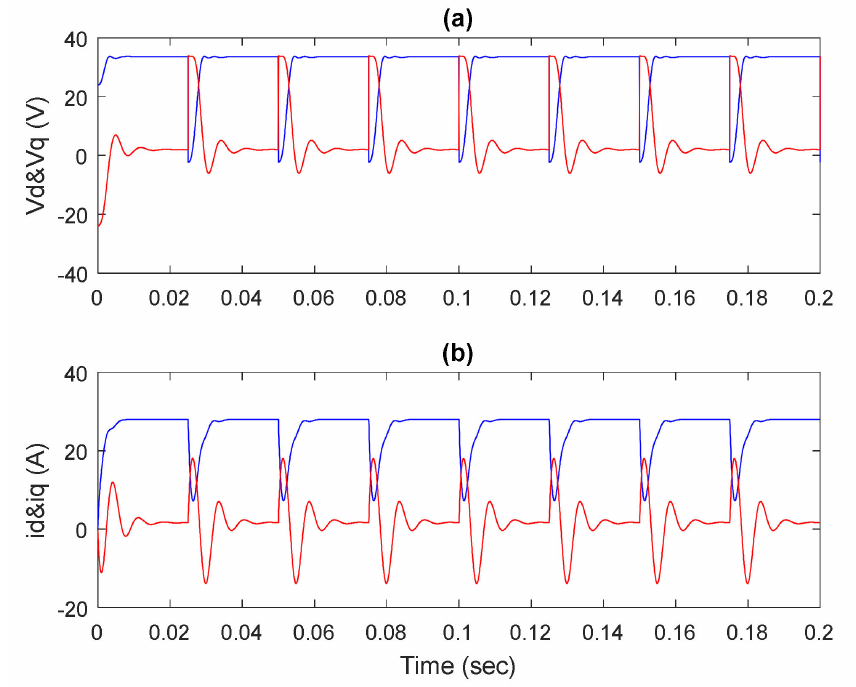
Figure 8. Voltage and current of the stepper motor in axes of d and q